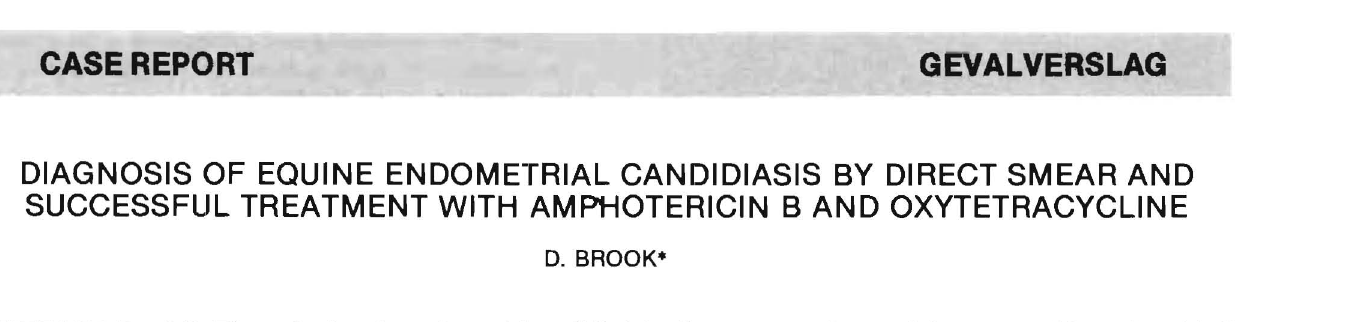
Fig. 1: Endometrial smear showing neutrophlls anti fungal elements. X400